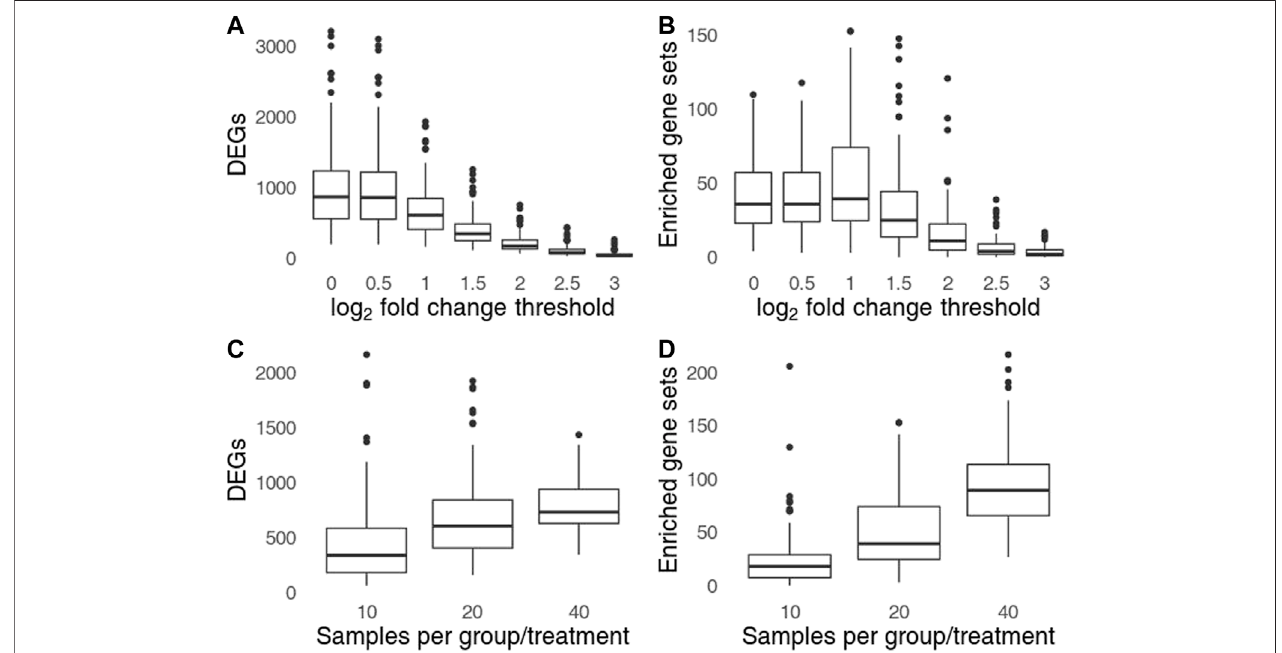
FIGURE4| In fl uenceoflog 2 foldchangetreshold (A,C) andthesamplesize (B,D) onthenumberofgenessigni fi cantinone,butnotintheothergroup (A,B) andthe numberofsigni fi cantgenesetsfoundinonegroup,butnottheother (C,D) .Toprowshowsthein fl uenceoflog 2 foldchangethresholdforsamplesizeof40pergroup(20 per group/treatment combination), bottom row shows the in fl uence of sample size for a log 2 fold change threshold set to 1.